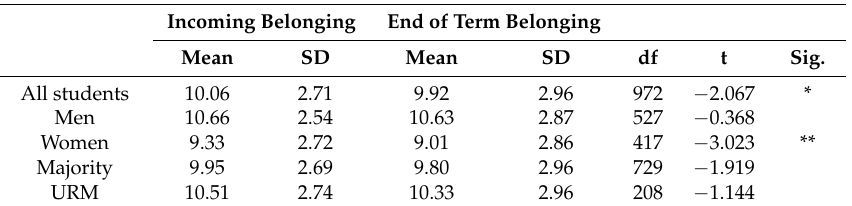
Table 2. Change in Sense of Belonging.